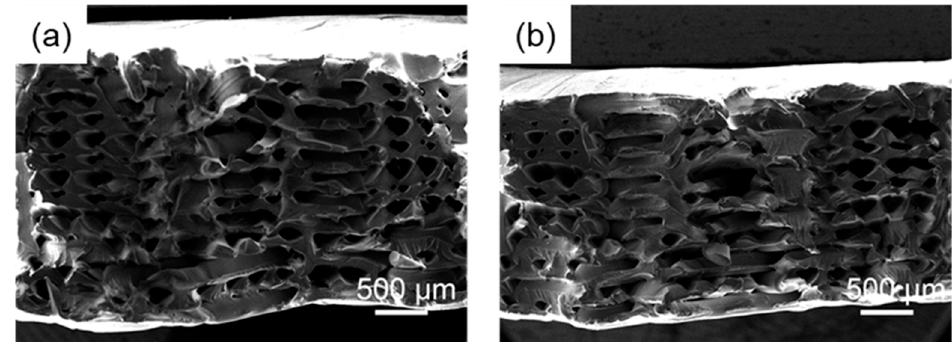
Figure 15. Tensile section, ( a ) 0.25 s second ultrasonic sample, ( b ) 0.5 s first ultrasonic sample.